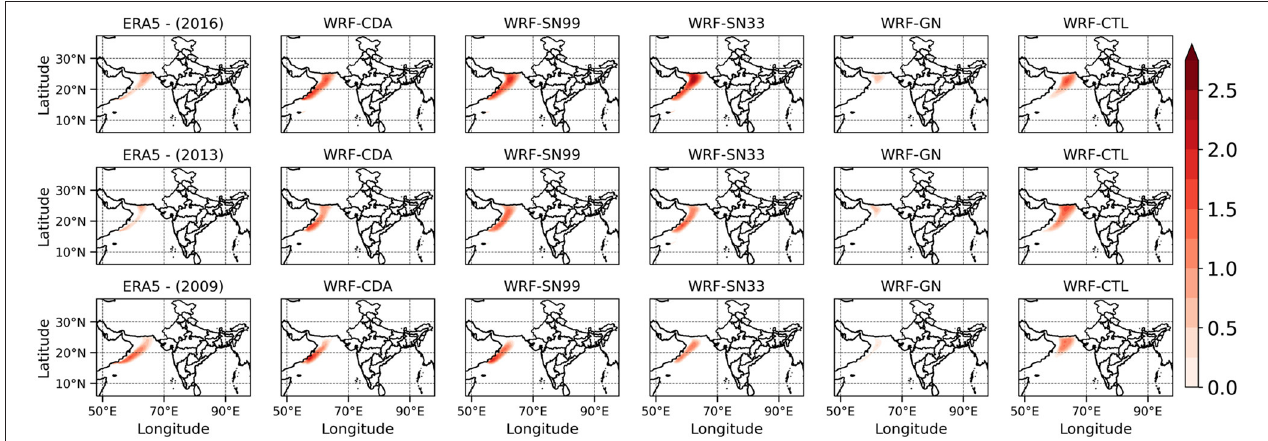
FIGURE 8 | The mean seasonal monsoon inversion [K, differences in the temperature between the 850 and 950 ( 1 T = T850 – T950 hPa)] for normal (2016), excess (2013), and drought (2009) years. First, second, third, fourth, fifth, and sixth columns are for the ERA5, WRF-CDA, WRF-SN99, WRF-S33, WRF-GN, and WRF-CTL, respectively. First row is for normal, second row is for excess, and third row is for drought Indian Summer Monsoon